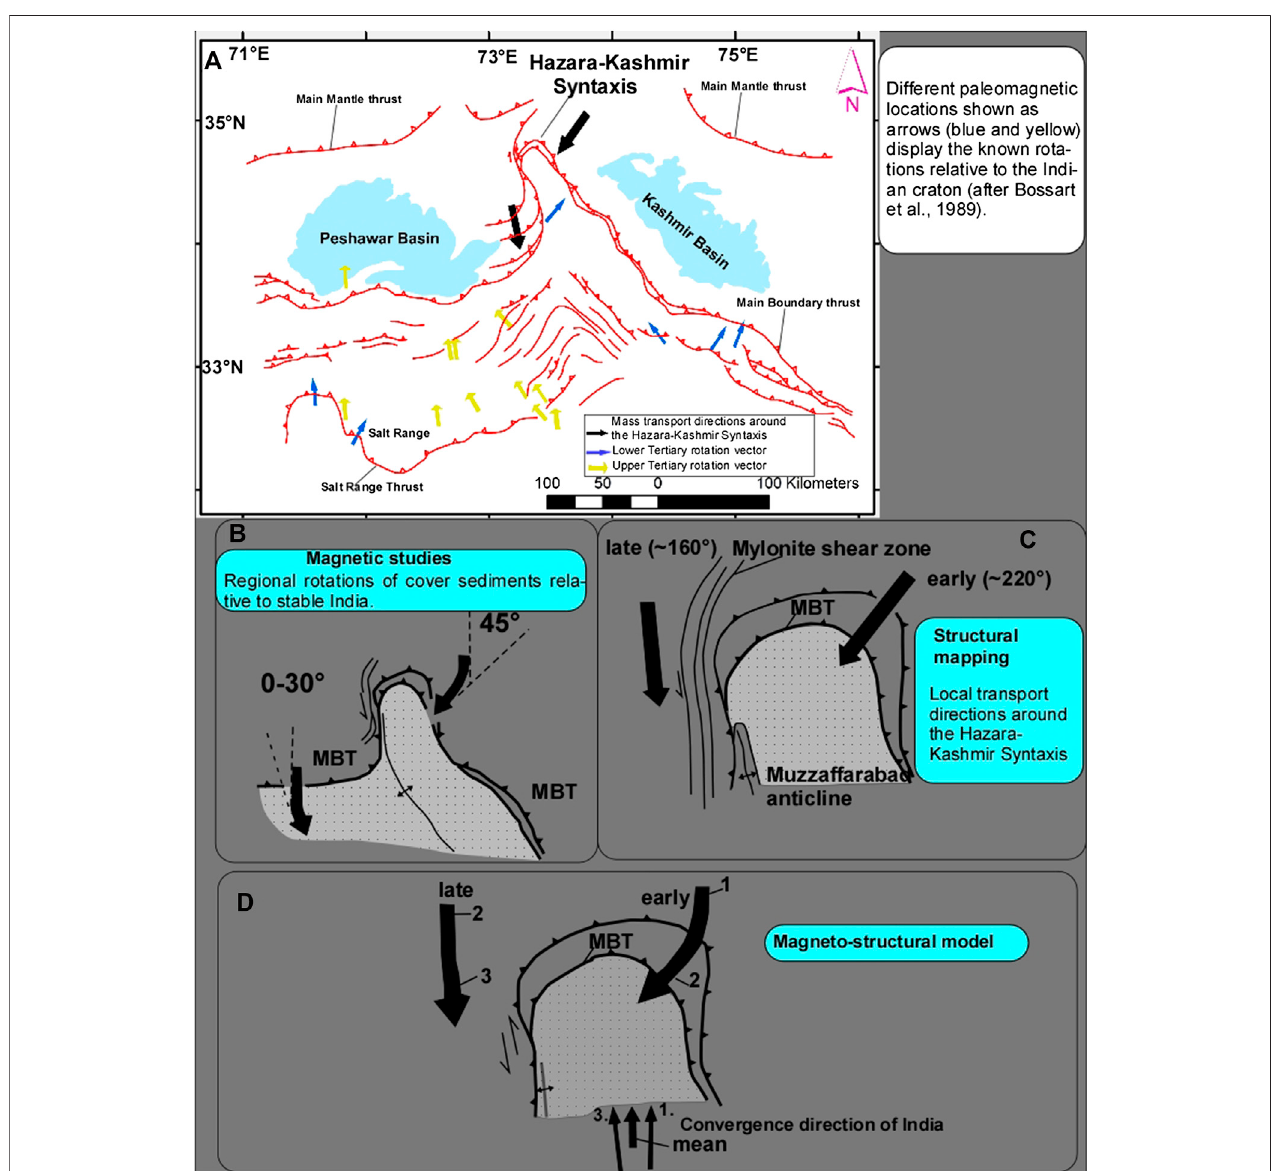
FIGURE 12 | (A) Different paleomagnetic locations shown as arrows (blue and yellow) display the known rotations relative to the Indian craton (after Bossart et al., 1989).Theclockwise,andanticlockrotationsoneithersideoftheHazara-Kashmirsyntaxiscomplementourmodel( Figure13 ). (B – D) Themagneto-structuralmodelfor the formation of the Hazara-Kashmir syntaxis are shown in three stages model (after Bossart et al., 1989; see Discussion for details).